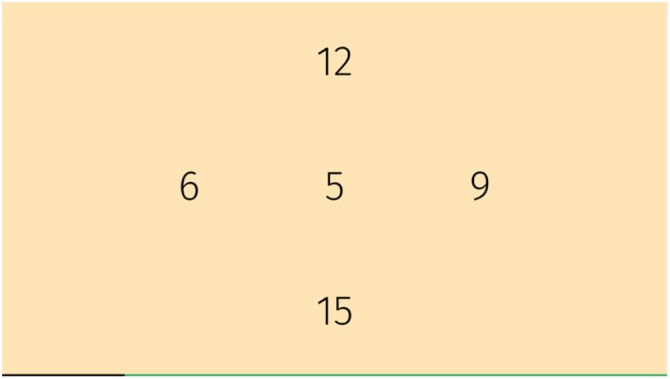
Flexi supports training of shifting attention.